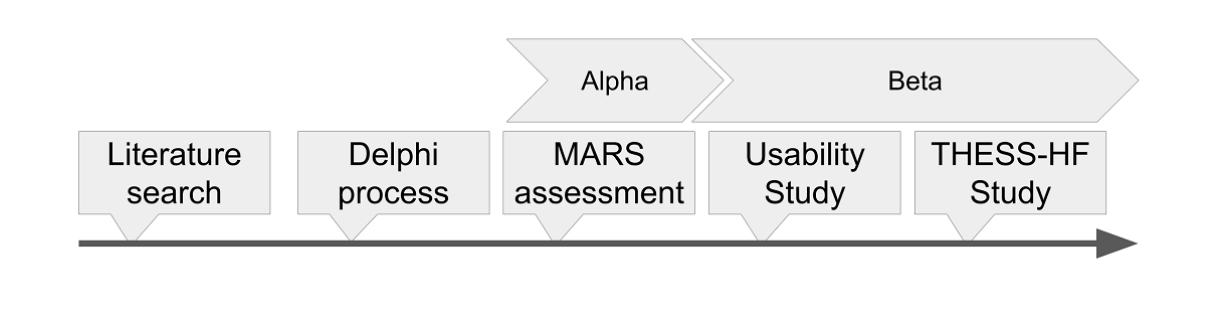
Figure 1. A timeline of the various parts of the evidence-based app development process, along with concurrent app versions. Note that the timeframes are not represented to scale in this